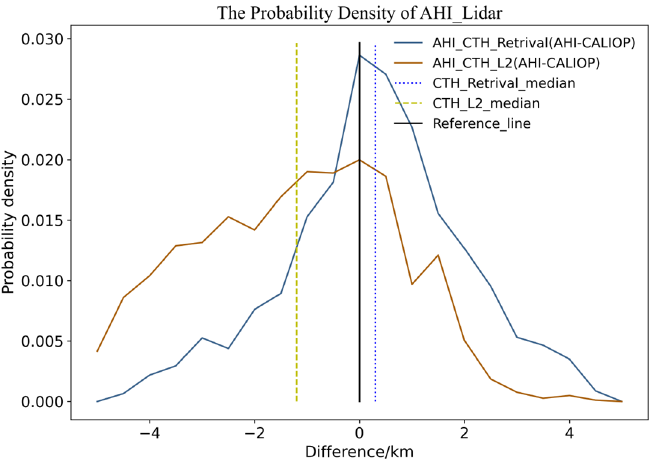
Figure 6. Comparison of CTH scatter. ( a ) Himawari-8 L2 CTH; ( b ) XGBoost CTH.